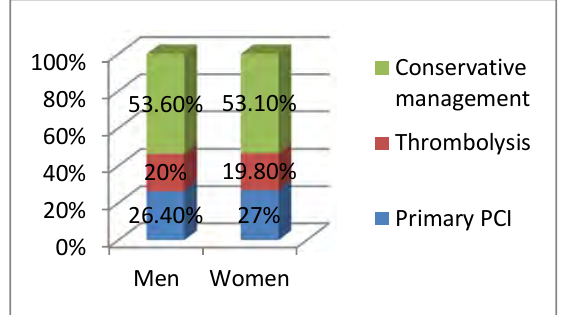
Fig 1: Management of